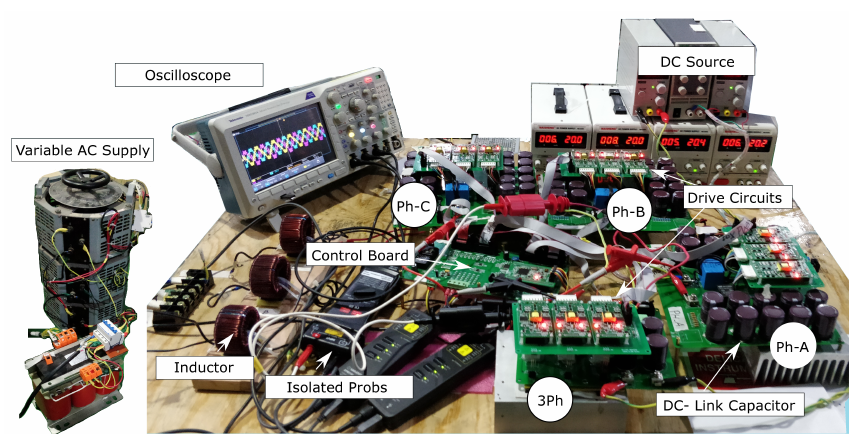
Figure 18. Low-voltage laboratory